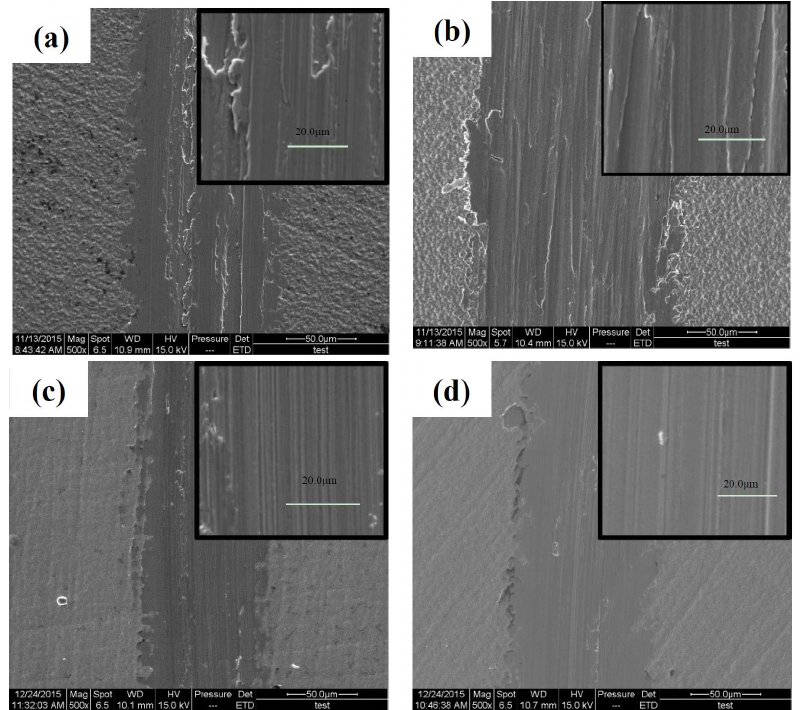
Figure 9. The SEM morphologies of wear traces on the surface of coatings: ( a ) Cu–Sn; ( b ) Cu–Sn–PTFE;